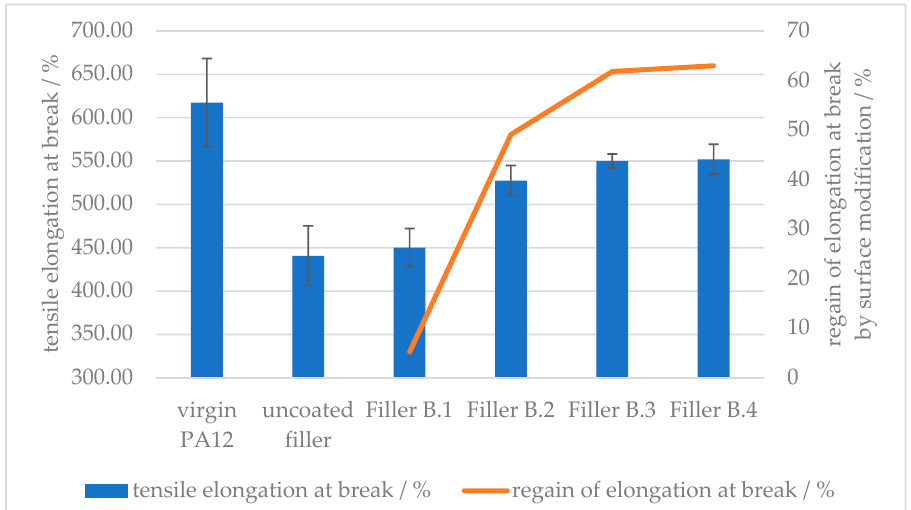
Figure 12. Effect of the amount of surface modifier on the tensile elongation at the break of amino hexanoic acid-treated, CaCO 3 -filled PA12 composites.